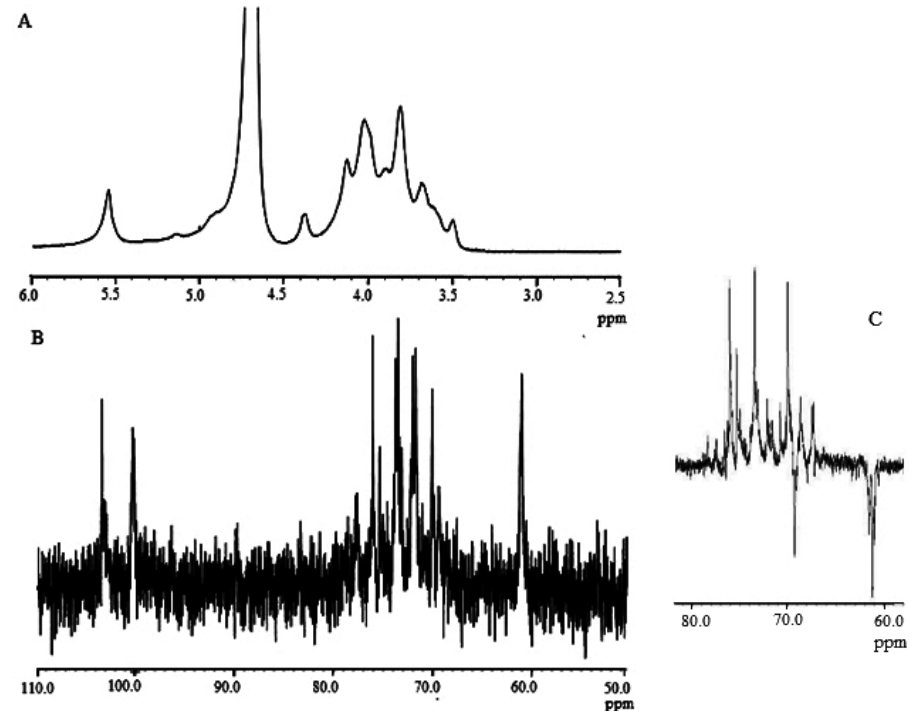
Figure 5. ( A ) 1 H-NMR spectrum (600 MHz, D O, 50 °C); ( C ) DEPT-135- 13 C (150 MHz, D (150 MHz, D 2 spectrum (600 MHz, D O, 50 °C) of F1 in aqueous 2